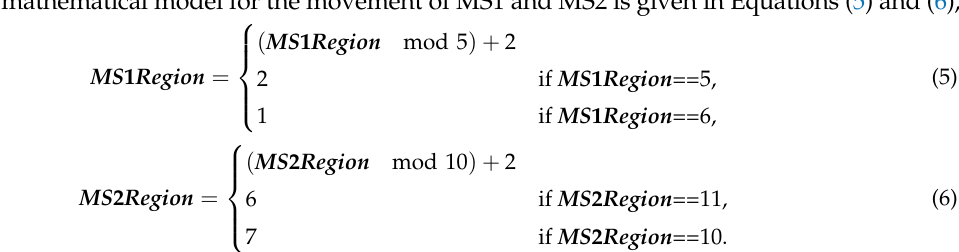
Figure 1. The mathematical model for the movement of MS1 and MS2 is given in Equations (5) and (6), respectively: